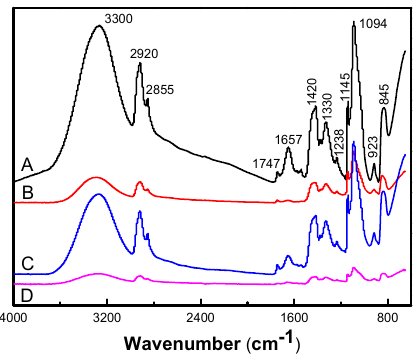
Figure 5. FT-IR (Fourier transform infrared spectroscopy) of AgCl / PVA / PEG / CS hydrogels loaded with ( A ) 0 mM, ( B ) 2.5 mM, ( C ) 5 mM, and ( D ) 7.5 mM AgCl NPs.